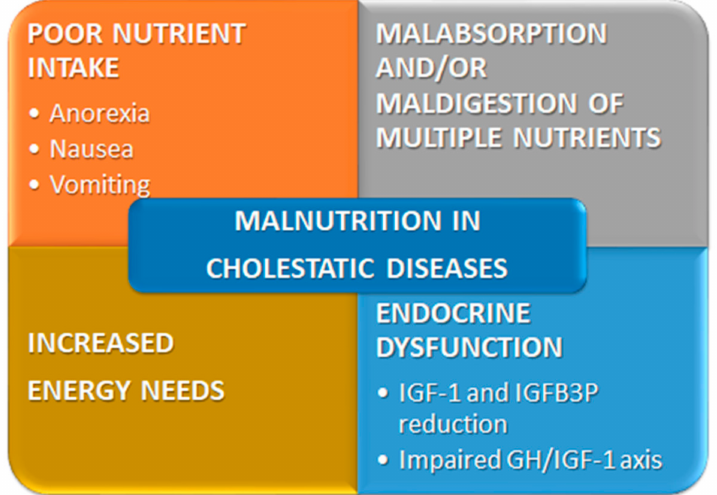
Figure 3. Main factors that determine malnutrition in pediatric chronic cholestatic liver disease. GH, growth hormone; IGFB3P, insulin-like growth factor binding protein 3; IGF-1, insulin-like growth